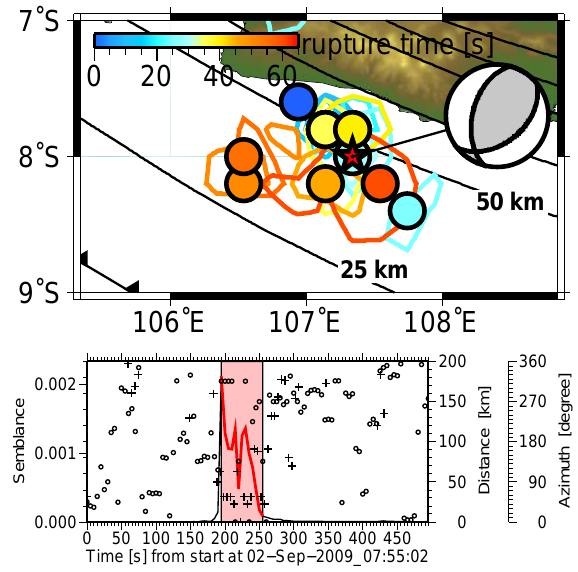
Fig. 6. As in Fig. 3 but for the M 7 . 4 Java earthquake on 2 Septem- ber